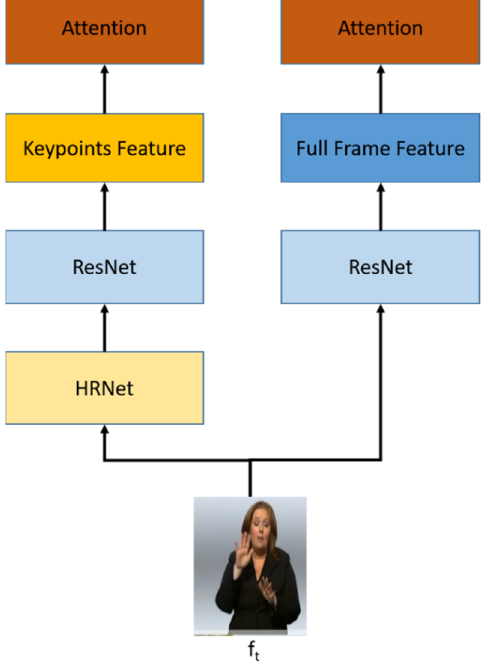
Figure 2. The spatial module architecture uses multi-stream input. RGB stream as a full-frame feature and keypoints stream as a keypoint features.